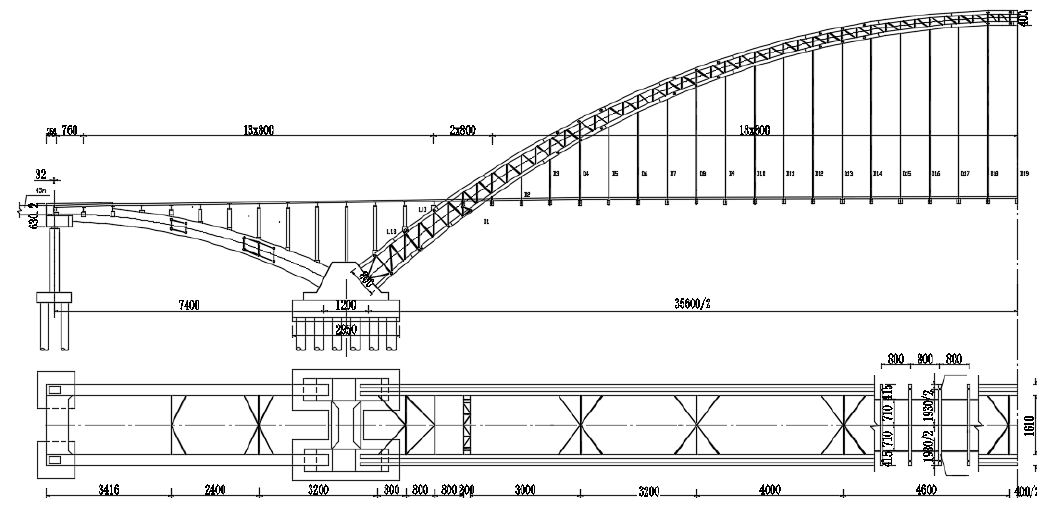
Table 1. The longitudinal beam section of deck to be reinforced